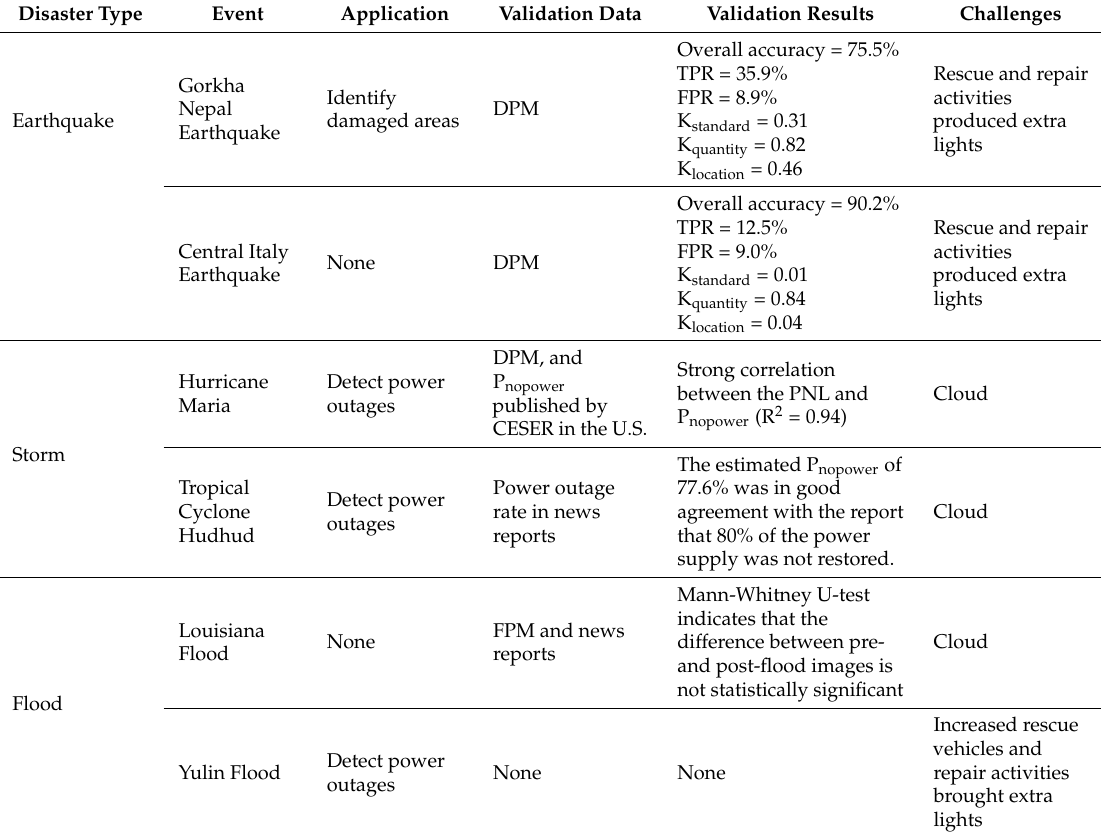
Table 11. The applications and challenges of using DNB daily observations in disaster